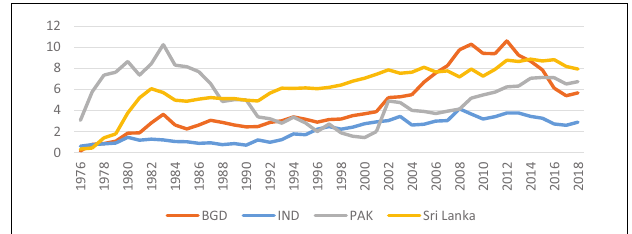
FIGURE 1 | Remittance inflows as a percentage of GDP from 1976 to 2018. Source: author calculation by using WDI data set.